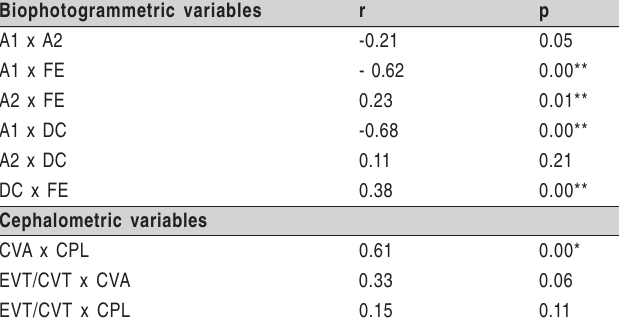
Table 2 - Correlation between the different craniocervical postures evaluated in each